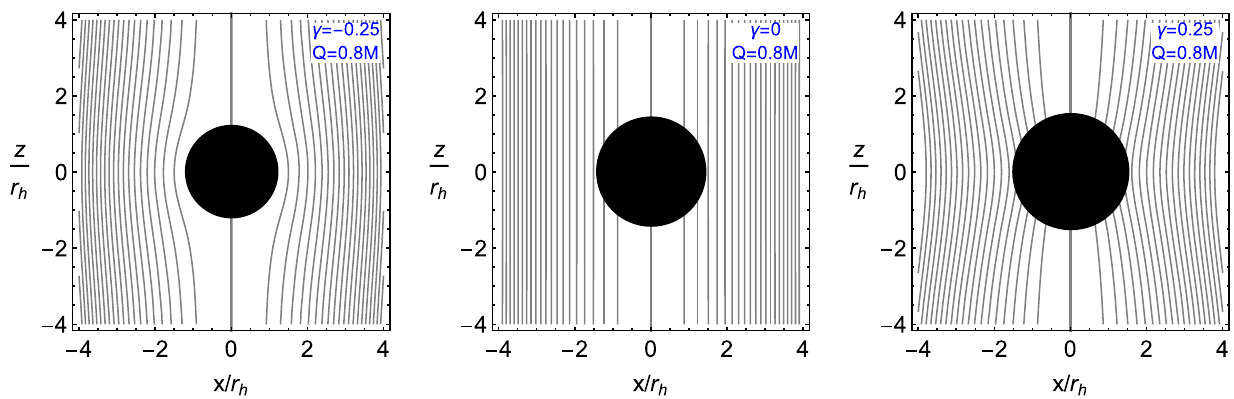
Fig. 4 Magnetic field lines around an EMS BH for different values of the parameter γ . Here we fixed BH charge at Q / M = 0 . 8 and take β = 1